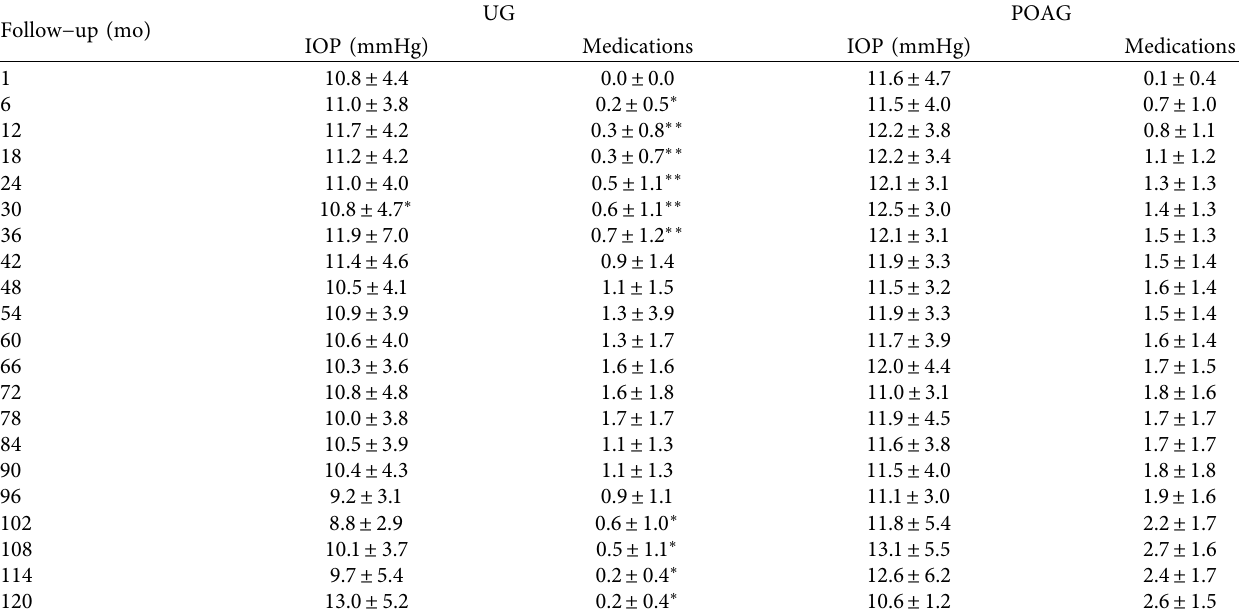
UG: uveitic glaucoma. POAG: primary open angle glaucoma. IOP: intraocular pressure (mean ± standard deviation). “Medications” indicates the number of different antiglaucoma medications applied regardless of their concentration and frequency. ( ∗ P < 0 . 05, ∗∗ P < 0 . 01 Student’s t-